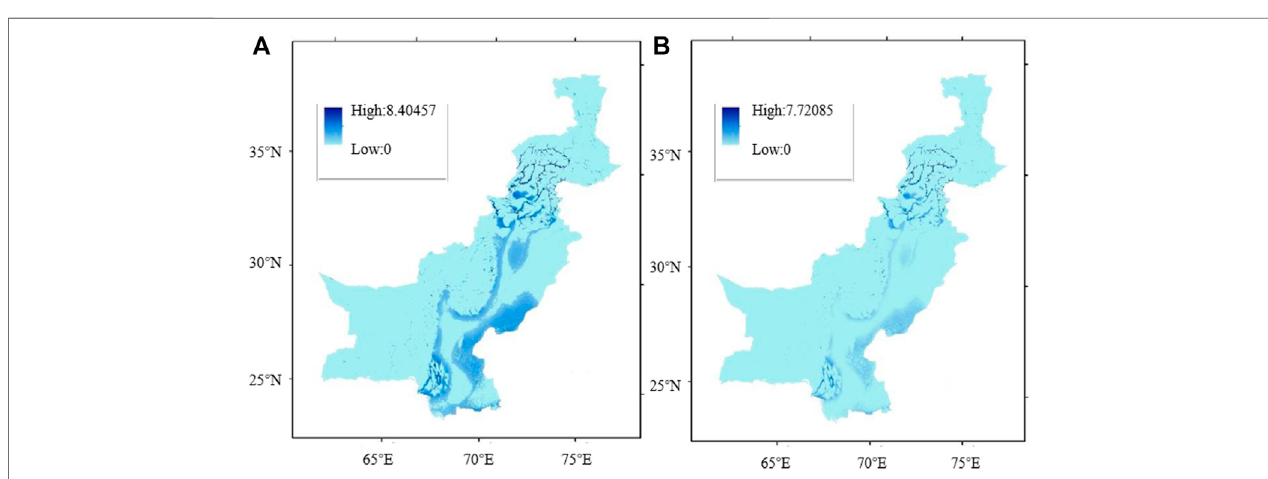
FIGURE 8 | Schematic diagram of the fl ood risk under the future scenario (SSP5-8.5). (A) 100-year fl ood process value. (B) 20-year fl ood process value.